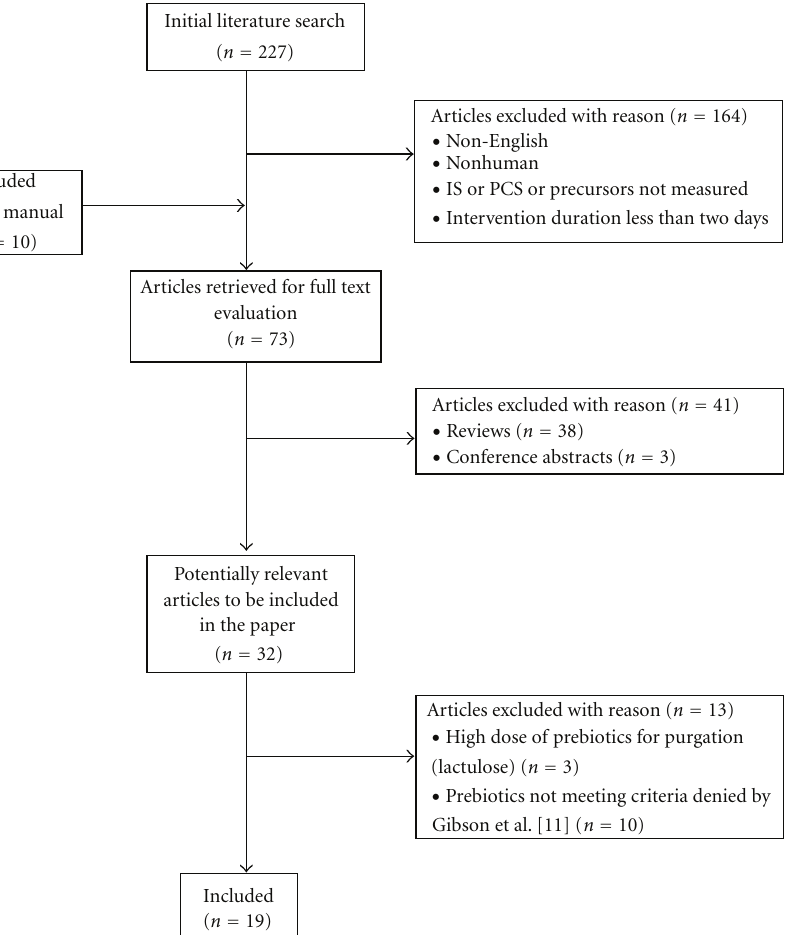
Figure 1: Search methodology for the PCS and IS literature